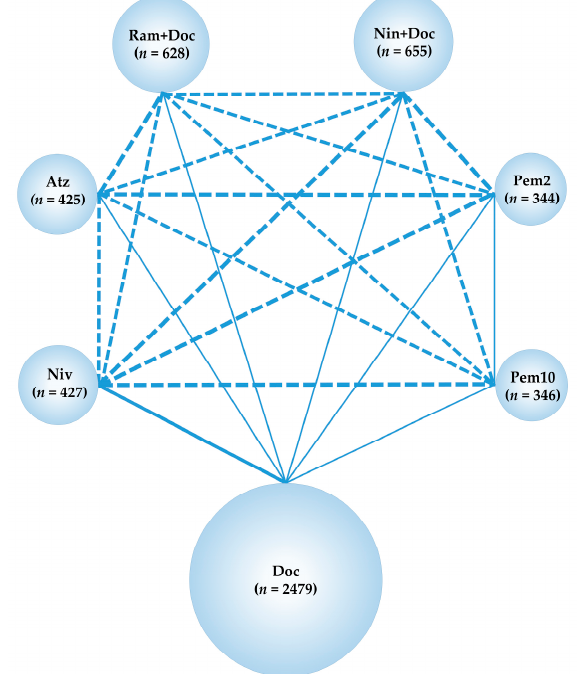
Figure 9. Network map of the analysis comparing the efficacy of the seven treatments, Doc, Ram+Doc, Niv, Atz, Pem2, Pem10, and Nin+Doc on the overall survival of participants of six RCTs, REVEL, CheckMate057, CheckMate017, OAK, KEYNOTE-010, and LUME-Lung 1. Solid lines represent randomized controlled trials (RCTs), and relative thickness represents the number of included studies. The dashed line reveals the absence of RCTs, suggesting that an indirect treat- ment comparison could be attempted. Circle size reflects the proportion of patients included in each treatment group. Ram+Doc, ramucirumab plus docetaxel; Niv, nivolumab; Atz, atezoli- zumab; Pem2, pembrolizumab 2 mg/kg; Pem10, pembrolizumab 10 mg/kg; n , number of patients. Furthermore, five RCTs, REVEL, CheckMate057, OAK, KEYNOTE-010 and LUME- Lung 1, were also included in the analysis that compared the effects of the six treatments, Doc, Ram+Doc, Niv, Atz, pem 2 mg/kg or 10 mg/kg (Pem pooled), and Nin+Doc on the OS of the non-squamous subgroup (Table S6). In addition, four RCTs, REVEL, Check- Mate017, OAK and KEYNOTE-010, were included in the analysis that compared the effi- cacy of the five treatments, Doc, Ram+Doc, Niv, Atz and Pem (pooled), on the OS of the squamous subgroup, (Table S7). A further analysis compared the effects of the seven treat- ments, Doc, Ram+Doc, Niv, Atz, Pem2, Pem10, and Nin+Doc, on the PFS for overall par- ticipants of six RCTs, REVEL, CheckMate057, CheckMate017, OAK, KEYNOTE-010, and LUME-Lung 1. (Table S8). In addition, another analysis compared the effects of seven treatments, Doc, Ram+Doc, Niv, Atz, Pem2, Pem10 and Nin+Doc, on safety, as indicated by G3-5AEs, of the overall participants of six RCTs, REVEL, CheckMate057, Check- Mate017, OAK, KEYNOTE-010 and LUME-Lung 1 (Table S9). The results of ranking assessment as indicated by SUCRA value are presented (Table S10).